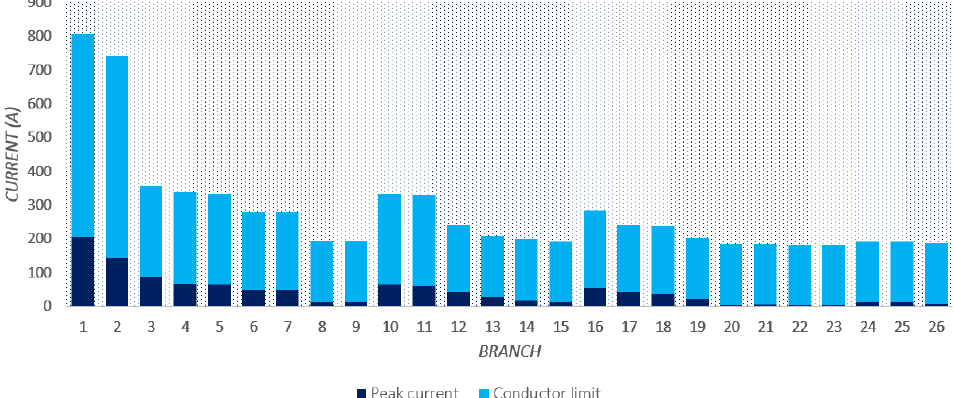
Figure 8. Behavior of the current in the branches for the IEEE 27-bus system